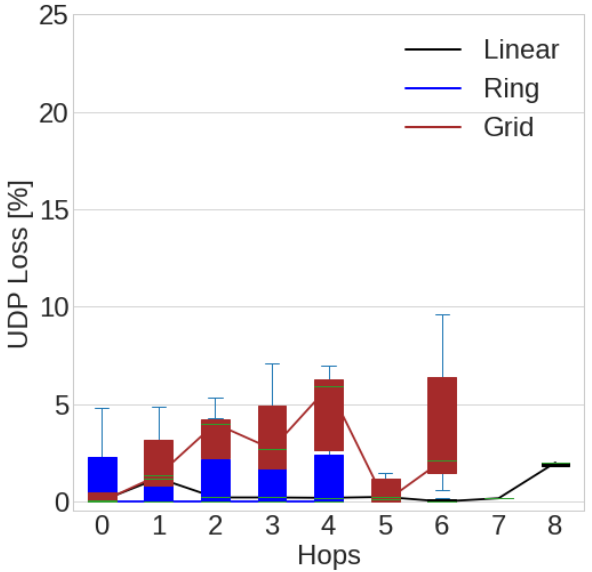
Figure 25. W-iLab2.t UDP loss.